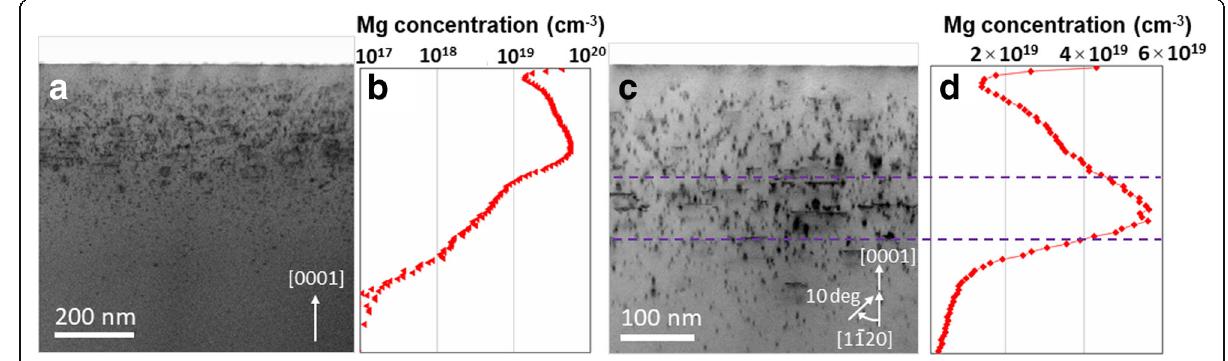
Fig. 1 a Cross sectional bright field STEM image of Mg implanted GaN sample obtained along [1120] axis and b corresponding depth profile of Mg obtained using SIMS. For better visualization of the defects and their relation to Mg concentration, imaging is carried out under off-zone axis condition as shown in c . Mg profile corresponding to c is shown in d in linear scale where line defects are observed in a narrow region having highest Mg